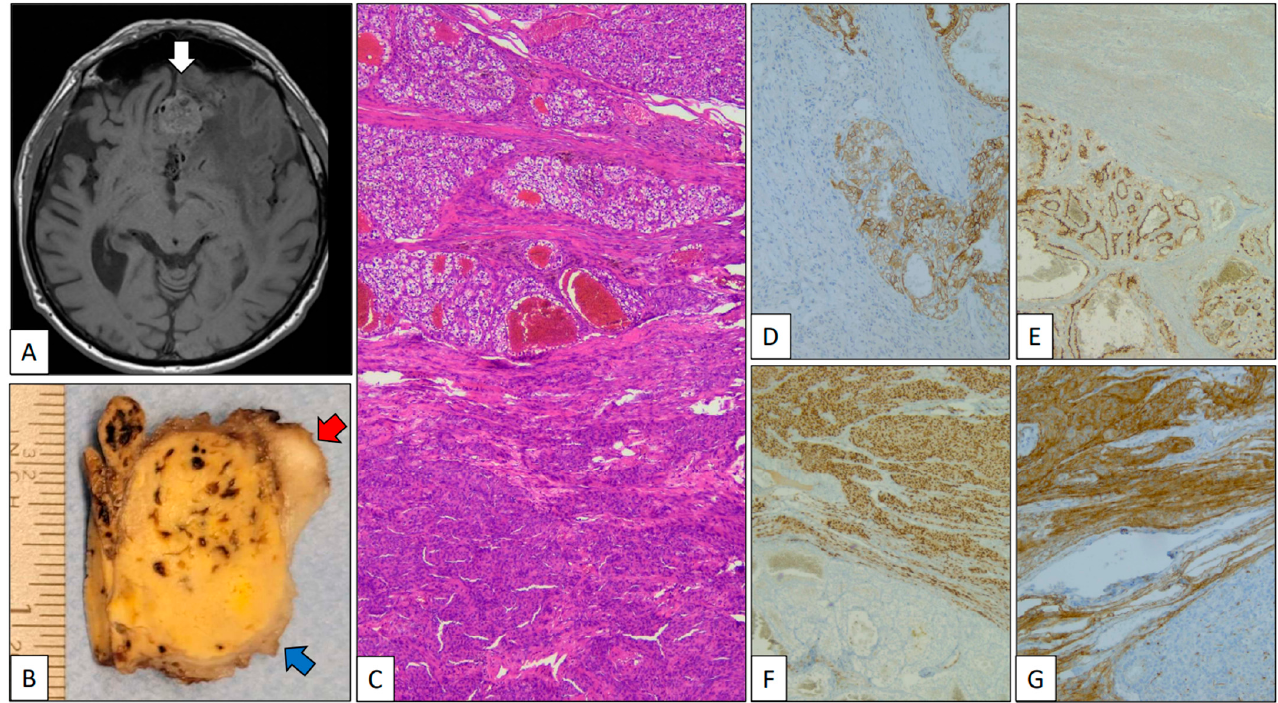
Figure 2. Clear cell renal cell carcinoma metastasizing in meningioma . ( A ) Axial MR of the brain showing an extra-axial heterogeneous fronto-basal tumor mass (white arrow). ( B ) Partial view of a part of the gross specimen showing a mixed yellow-brownish (clear cell renal cell carcinoma, blue arrow) and whitish (meningioma, red arrow) appearance. ( C ) Panoramic view of the interface between clear cell renal cell carcinoma (top) and meningioma (bottom). Positive immunostaining with carbonic anhydrase IX ( D ) and CD10 ( E ) in the clear cell renal cell carcinoma and progesterone receptor ( F ) and EMA ( G ) in the meningioma.